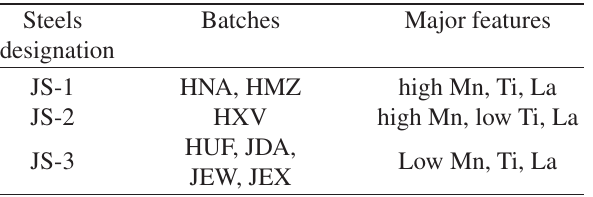
Table 1. Studied model and semi-commercial FeCrMn(La/Ti) alloys.